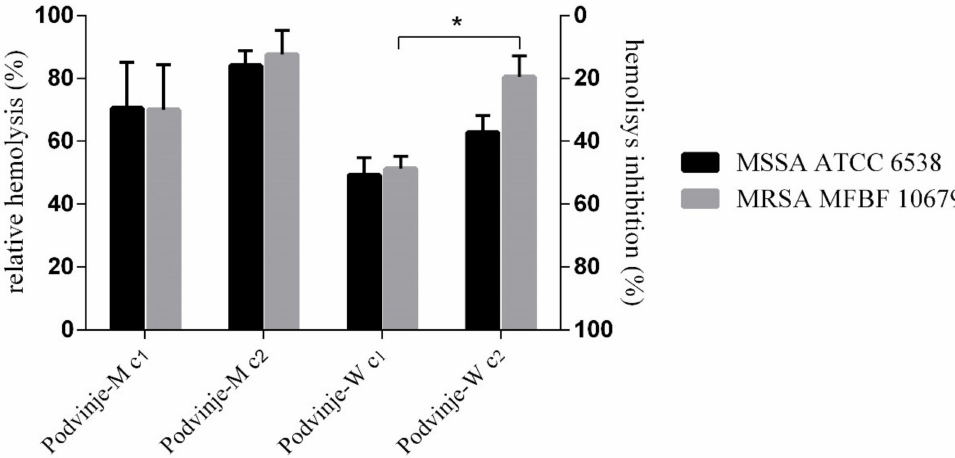
Figure 4. Anti-hemolytic activity of E. cicutarium water (Podvinje-W) and methanolic (Podvinje-M) extracts from the Podvinje locality on MSSA and MRSA strains (*, statistically significant difference among c 1 and c 2 ; c 1 = MIC/2; c 2 = MIC/4; p ≤ 0.01; t -test).